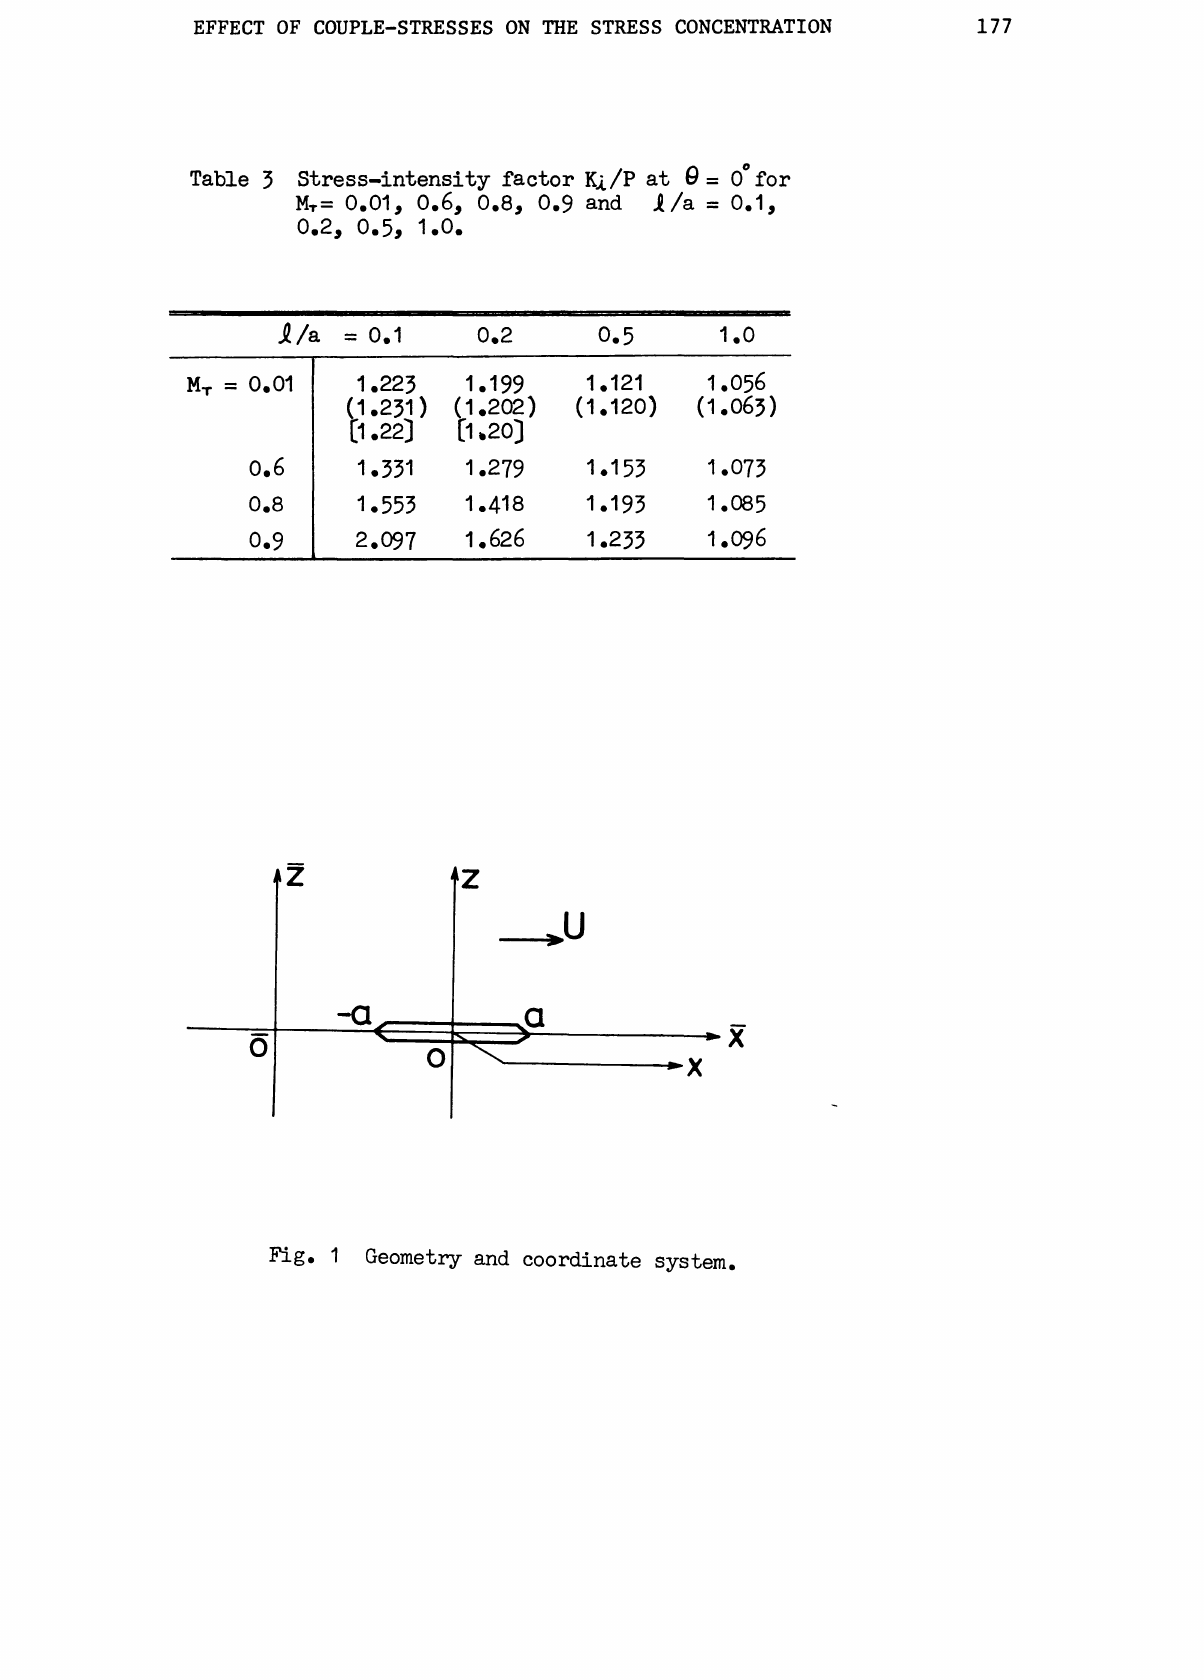
Stress-intensity factor Ki/P at @